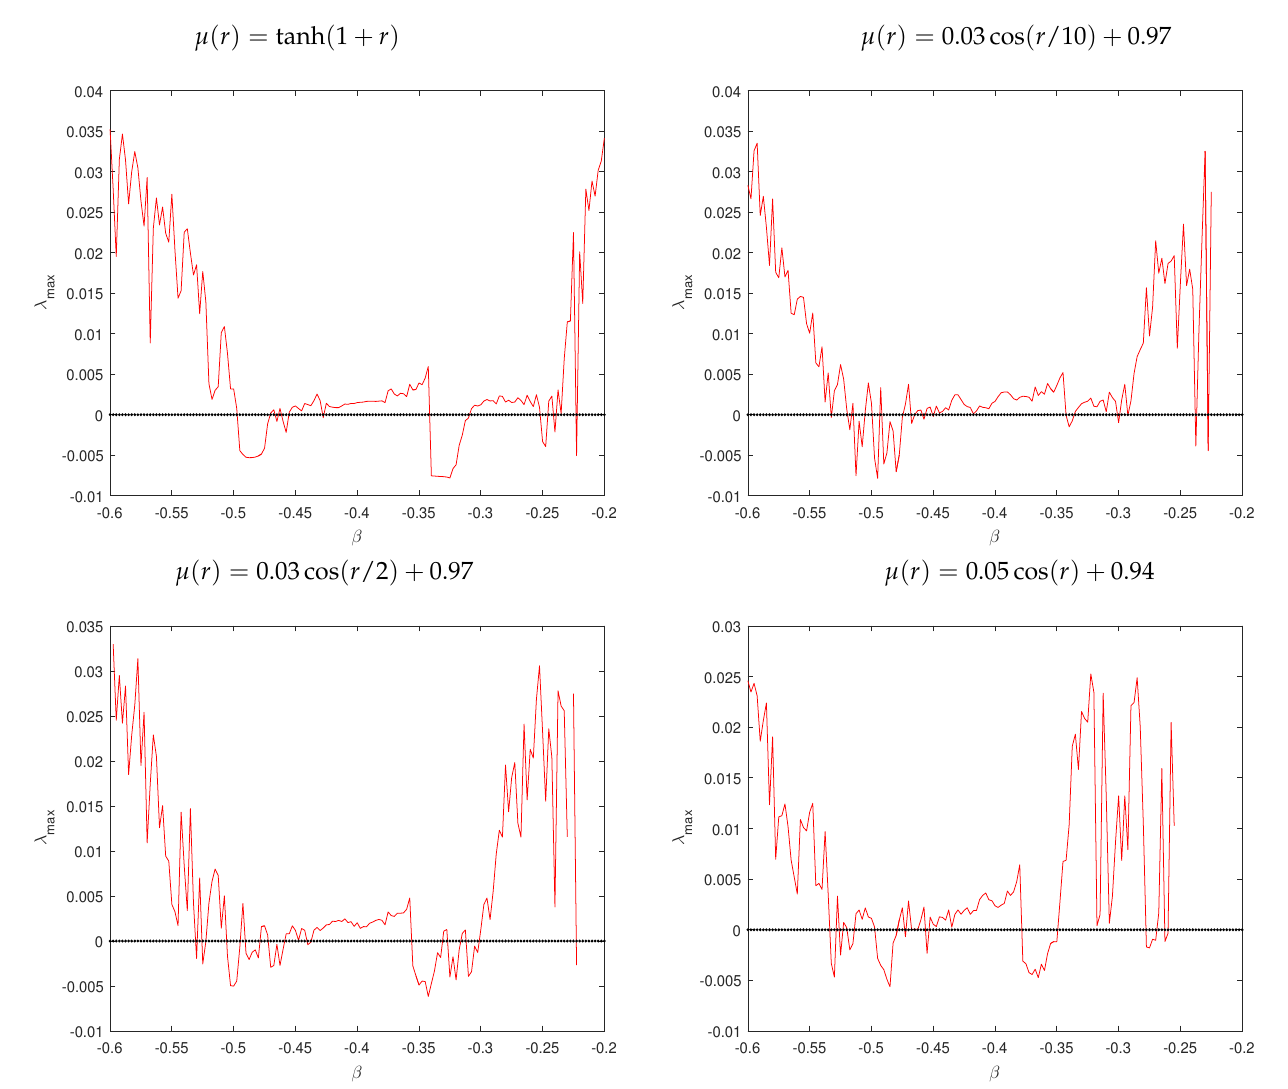
Figure 4. Plots of the largest Lyapunov exponents versus the parameter β of the system (8) with distinct functions of the fractional